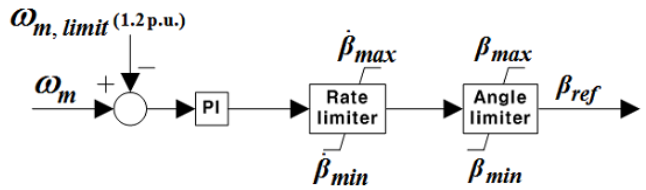
Figure 2. Pitch angle